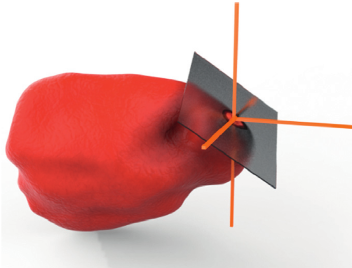
Figure 10: Schematic diagram of hematoma under the Eight Diagrams algorithm.